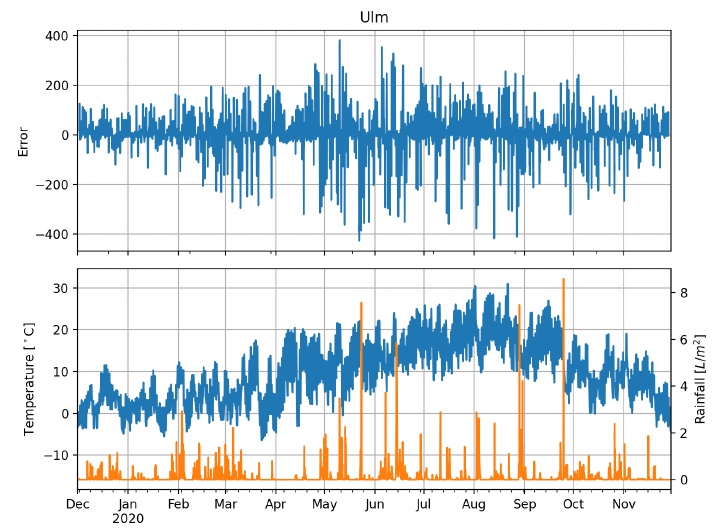
Figure 12. Error of LSTMconv Model and temperature/rainfall in Ulm from 1 December 2019